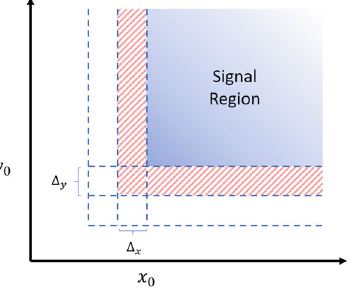
Fig. 2 Control regions used in the extended ABCD methods. The upper right region is the signal region, while the rest are the control regions. The hatched regions are the nominal regions used in an ABCD method,whiletheotheropenregions(inadditiontothehatchedregions) are incorporated in the extended ABCD